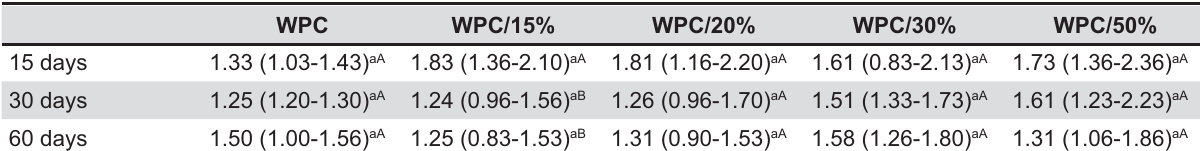
Table 2- (cid:9)(cid:29)(cid:8)(cid:4)(cid:2)(cid:6)(cid:3)(cid:9)(cid:6)(cid:3)(cid:4)(cid:9)(cid:16)(cid:6)(cid:3)(cid:13)(cid:8)(cid:9)(cid:18)(cid:15)(cid:9)(cid:2)(cid:3)(cid:30)(cid:6)(cid:17)(cid:17)(cid:6)(cid:7)(cid:18)(cid:16)(cid:12)(cid:9)(cid:2)(cid:3)(cid:14)(cid:11)(cid:7)(cid:16)(cid:6)(cid:7)(cid:8)(cid:9)(cid:15)(cid:18)(cid:16)(cid:9)(cid:13)(cid:16)(cid:18)(cid:28)(cid:20)(cid:10)(cid:9)(cid:6)(cid:7)(cid:9)(cid:7)(cid:19)(cid:8)(cid:9)(cid:8)(cid:31)(cid:6)(cid:11)(cid:28)(cid:6)(cid:7)(cid:8)(cid:4)(cid:9)(cid:20)(cid:8)(cid:16)(cid:2)(cid:18)(cid:4)(cid:10)(cid:24)(cid:9)(cid:27)(cid:2)(cid:15)(cid:15)(cid:8)(cid:16)(cid:8)(cid:3)(cid:7)(cid:9)(cid:11)(cid:18)!(cid:8)(cid:16)(cid:5)(cid:6)(cid:10)(cid:8)(cid:9)(cid:11)(cid:8)(cid:7)(cid:7)(cid:8)(cid:16)(cid:10)(cid:9)(cid:2)(cid:3)(cid:9) (cid:16)(cid:18)!(cid:10)(cid:9)(cid:2)(cid:3)(cid:4)(cid:2)(cid:5)(cid:6)(cid:7)(cid:8)(cid:9)(cid:10)(cid:7)(cid:6)(cid:7)(cid:2)(cid:10)(cid:7)(cid:2)(cid:5)(cid:6)(cid:11)(cid:11)(cid:12)(cid:9)(cid:10)(cid:2)(cid:13)(cid:3)(cid:2)(cid:14)(cid:5)(cid:6)(cid:3)(cid:7)(cid:9)(cid:4)(cid:2)(cid:15)(cid:15)(cid:8)(cid:16)(cid:8)(cid:3)(cid:5)(cid:8)(cid:10)(cid:9)(cid:6)(cid:17)(cid:18)(cid:3)(cid:13)(cid:9)(cid:7)(cid:19)(cid:8)(cid:9)(cid:17)(cid:6)(cid:7)(cid:8)(cid:16)(cid:2)(cid:6)(cid:11)(cid:10)(cid:9)(cid:2)(cid:3)(cid:9)(cid:8)(cid:6)(cid:5)(cid:19)(cid:9)(cid:20)(cid:8)(cid:16)(cid:2)(cid:18)(cid:4)(cid:9)(cid:21)(cid:20)(cid:22)(cid:23)(cid:24)(cid:23)(cid:25)(cid:26)(cid:24)(cid:9)(cid:27)(cid:2)(cid:15)(cid:15)(cid:8)(cid:16)(cid:8)(cid:3)(cid:7)(cid:9)(cid:28)(cid:20)(cid:20)(cid:8)(cid:16)(cid:5)(cid:6)(cid:10)(cid:8)(cid:9)(cid:11)(cid:8)(cid:7)(cid:7)(cid:8)(cid:16)(cid:10)(cid:9)(cid:2)(cid:3)(cid:9)